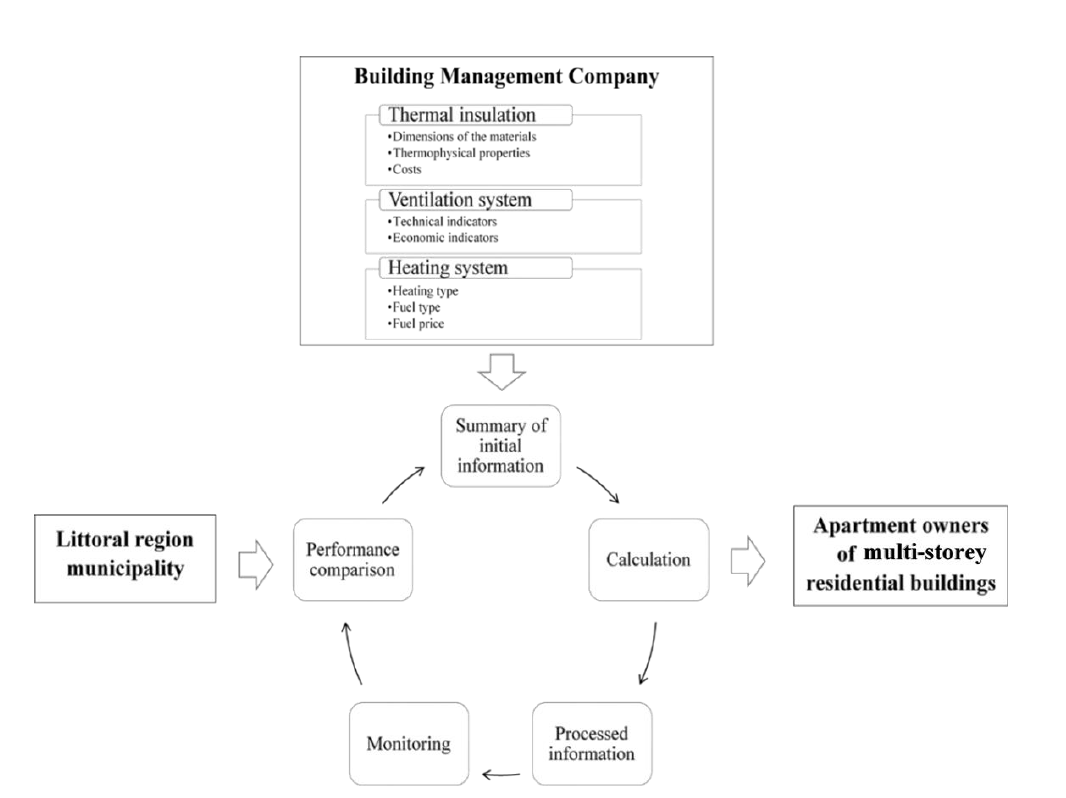
Fig. 4. The energy audit system in littoral regions (developed by the authors, based on Petrov, Puikevica-Puikevska & Zeltinsh,